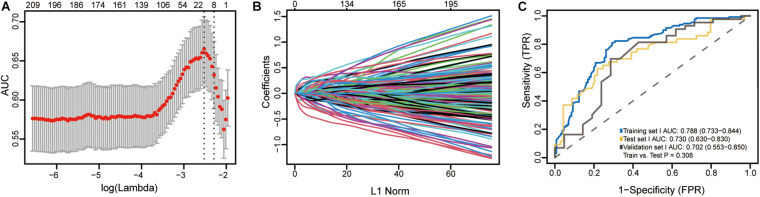
(A) Selection of tuning parameter (λ) in the LASSO model used 10-fold cross-validation in training set I by the 1 standard error of the minimum criteria (the 1-SE criteria). The AUC curve was plotted vs. log(λ). Dotted vertical lines were drawn at the optimal values using the minimum criteria and the 1-SE criteria. A λ value of 0.1013 with log (λ) of –2.290 was chosen. (B) LASSO coefficient profiles of the 1,590 CpGs. A coefficient profile plot was produced against the log (λ) sequence. (C) ROC curves showing discrimination ability of the methylation signature in training set I, test set I and validation set I.